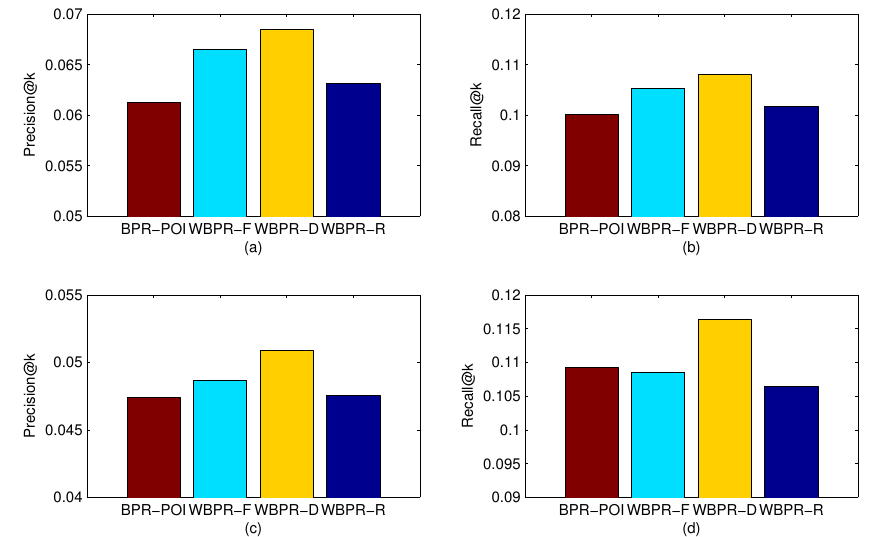
Figure 6. Impact of weight factors on the recommendation performance in Gowalla and Brightkite (Dimensionality = 10, k = 5). ( a ) Precision @ k in Gowalla; ( b ) Recall @ k in Gowalla; ( c ) Precision @ k in Brightkite; ( d ) Recall @ k in